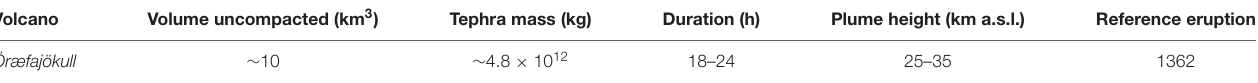
TABLE 1 | Volcanological parameters characterizing the 1362 eruption at Öræfajökull as reported in Thorarinsson, 1958. Volcano Volume uncompacted (km 3 ) Tephra mass (kg) Duration (h) Plume height (km a.s.l.)